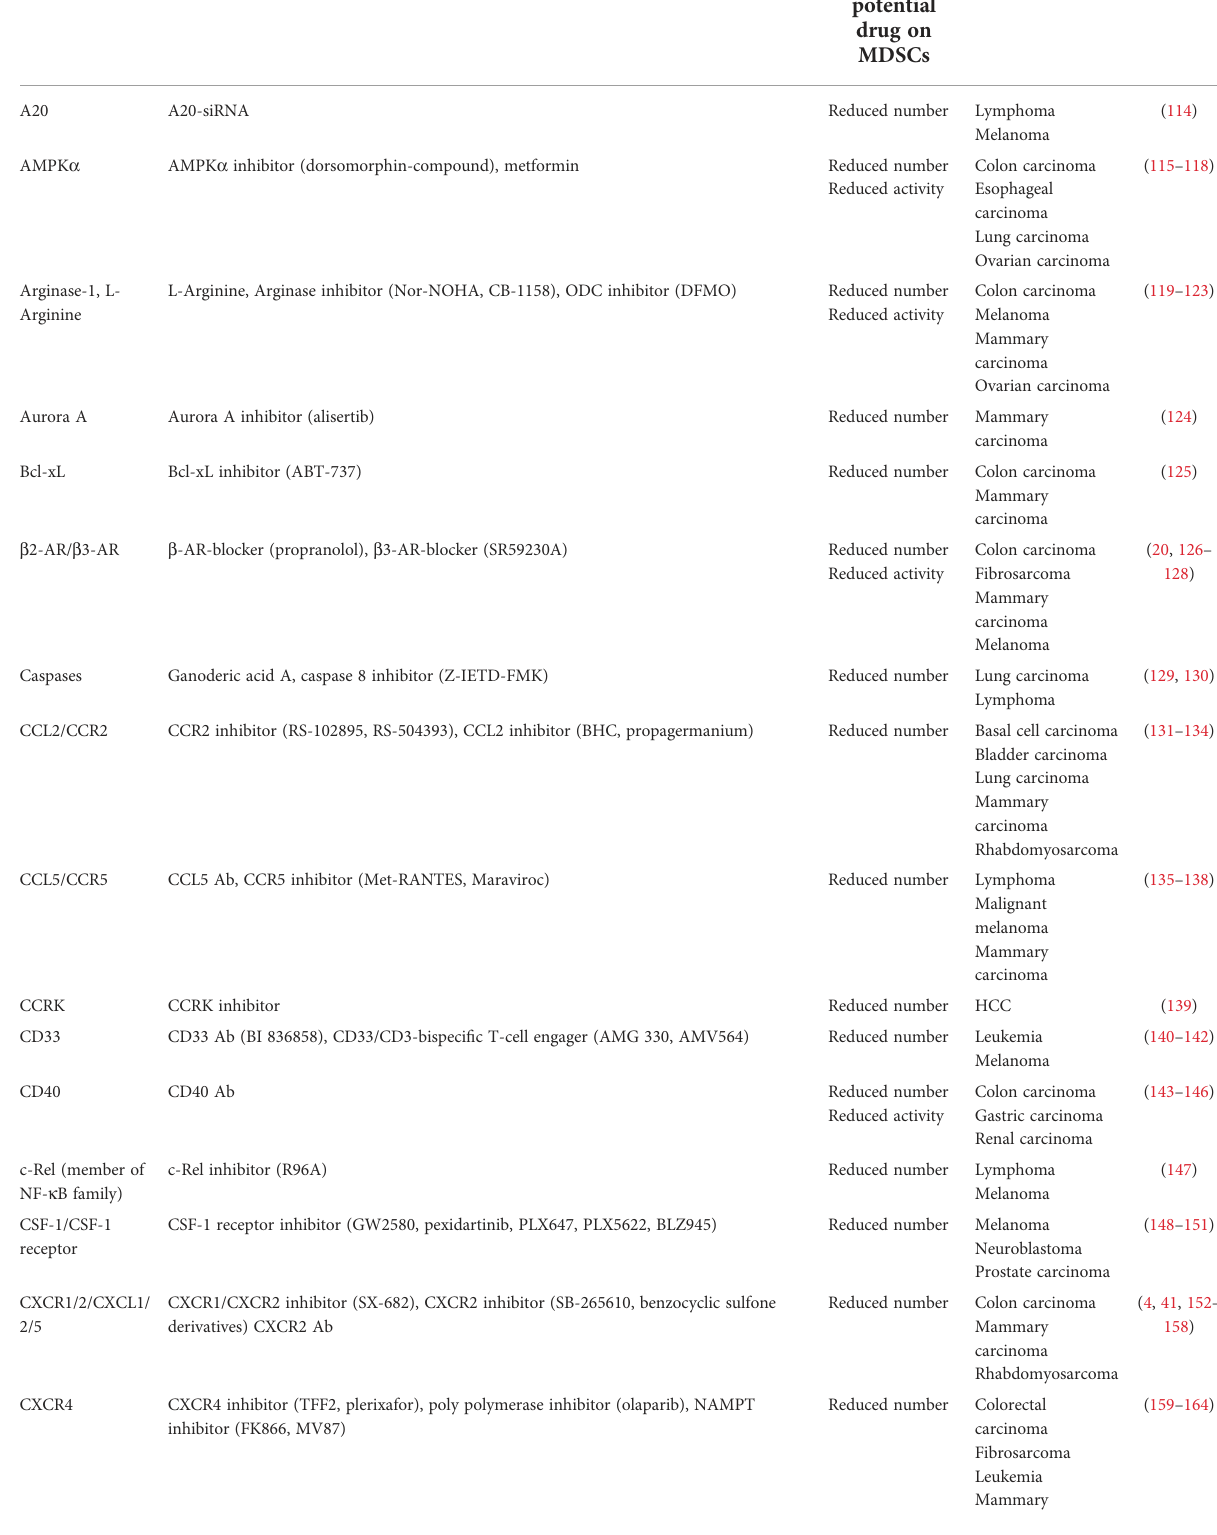
TABLE 2 Potential pharmacological targets on MDSCs in